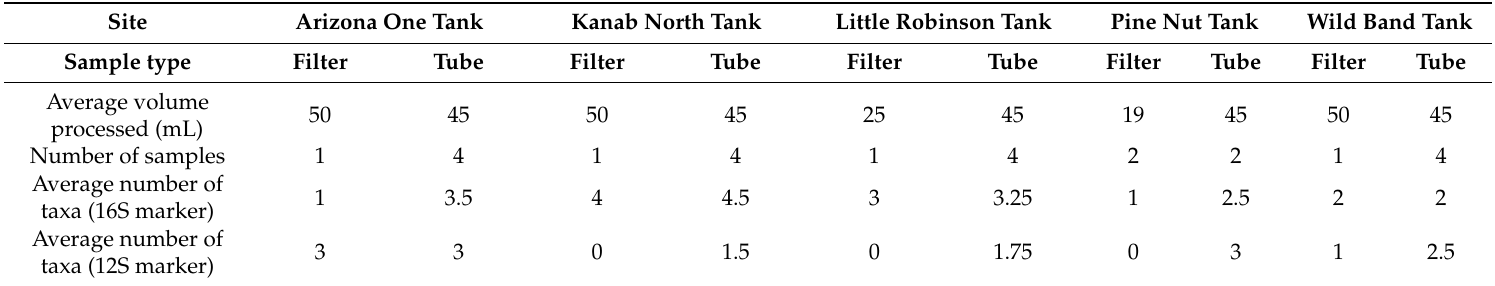
Table 2. Comparison of filtered versus centrifuge (tube) processed